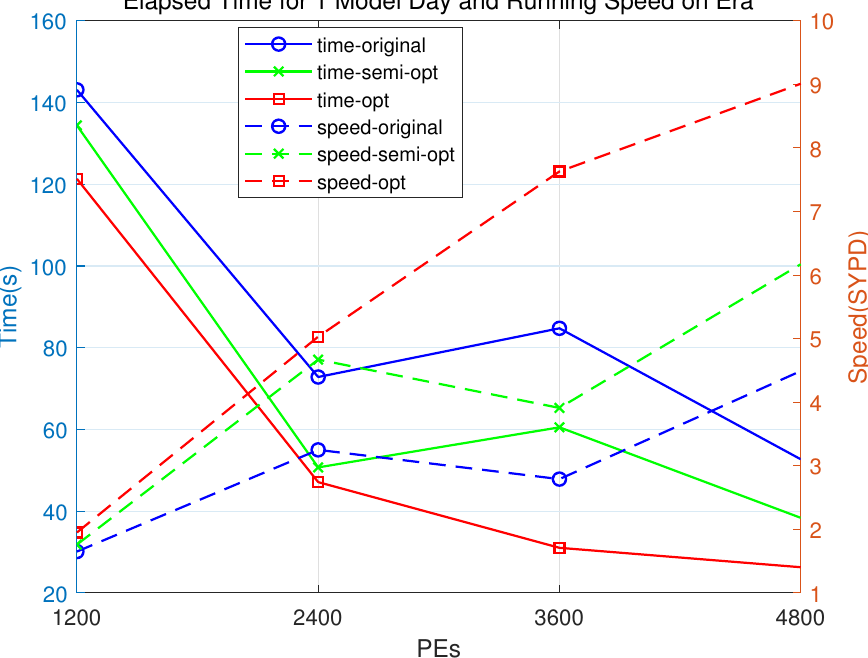
Figure 6. Elapsed time and speed of LICOM on